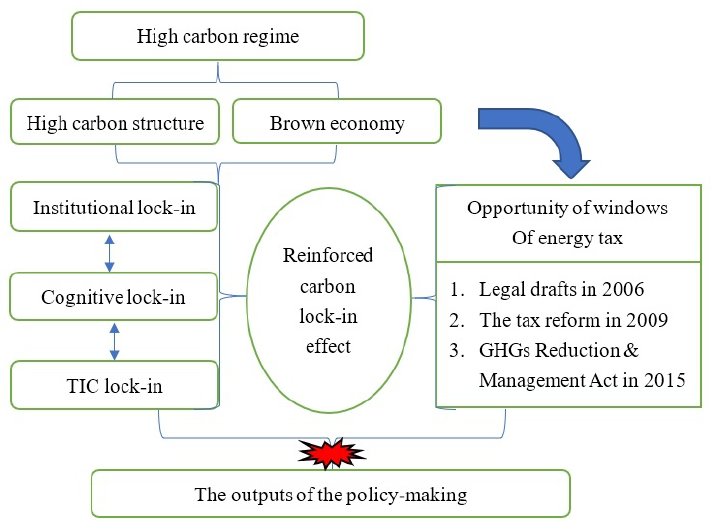
Figure 6. The reinforced carbon lock-in effect in Taiwanese carbon taxation legislation. Source: made by authors.